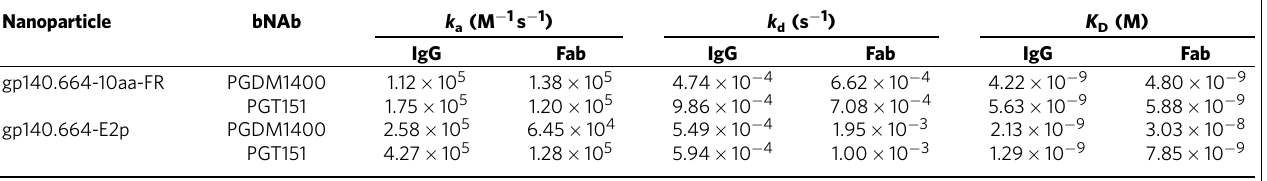
SPR, surface plasmon resonance. *SPR analysis of gp140 nanoparticle–bNAb binding kinetics was performed on a Biacore 3000 instrument using a custom wizard application (see details in